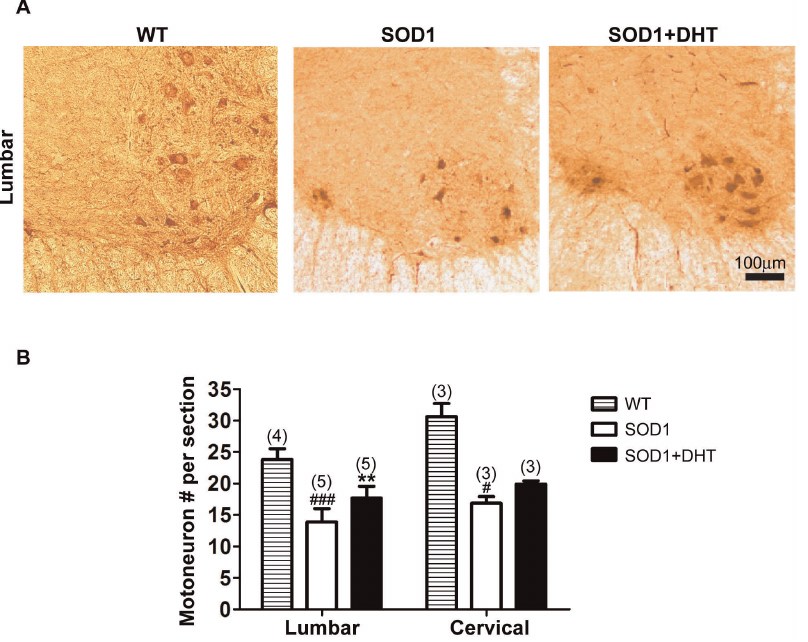
Figure 7. DHT improves motoneuron survival in SOD1 mice. A: SOD1 mice were implanted with either a DHT-filled or an empty silastic (control) tube at P75, and the lumbar spinal cord (L) 3-L5 was collected at P120, the symptomatic age. Cross-sectional pictures of the hemi-lumbar spinal cord in WT, control SOD1, and DHT-treated SOD1 mice are shown. B: There was a 41% reduction in motoneuron number in the L3–L5 of SOD1 mice (13.9 6 0.7, n=5) compared with WT mice at P120 (23.8 6 0.9, n=4, p , 0.0001). DHT-treated SOD1 mice contained 27% more motoneurons (17.7 6 0.8, n=5, p =0.0093) compared with control SOD1 mice. In the cervical spinal cord, there were 45% less motoneurons in SOD1 mice (16.8 6 0.7, n=3, p =0.015) compared with WT mice at P120 (30.6 6 1.5, n=3). There were 18% more motoneurons in DHT-treated SOD1 mice (19.9 6 0.4, n=3, p =0.467) compared with control SOD1 mice. Data are mean 6 SEM. ** p , 0.01(compared with control SOD1 mice), # p , 0.05, ### p , 0.001 (compared with age-matched WT